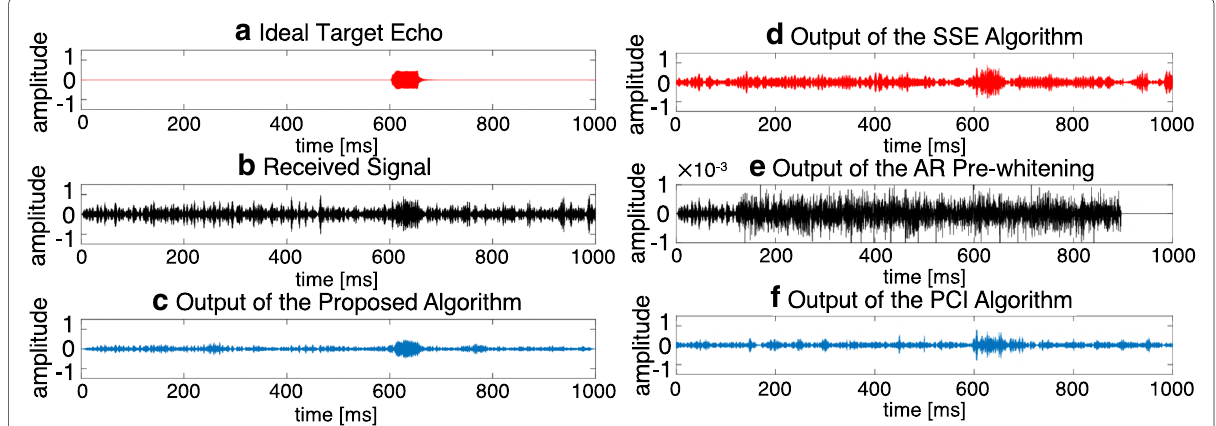
Fig. 7 Waveforms of a ideal target echo signal, b received signal, c output signal using the proposed algorithm, d output by the SSE algorithm, e output by the AR pre-whitening, and f output by the PCI algorithm (input SRR = − 12